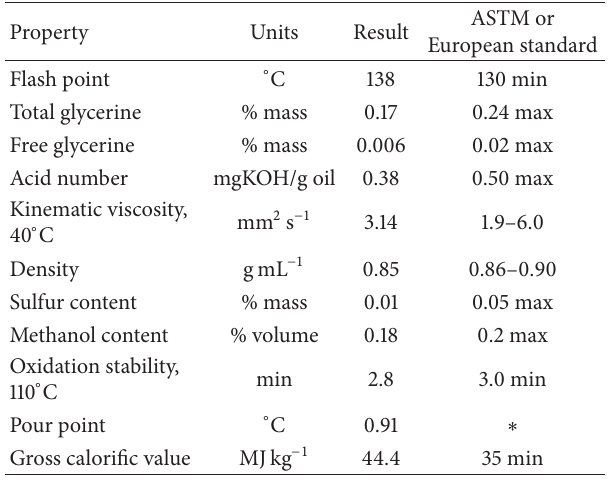
Table 3: Properties of Cha˜nar biodiesel compared to ASTM D6751 or EN 14214